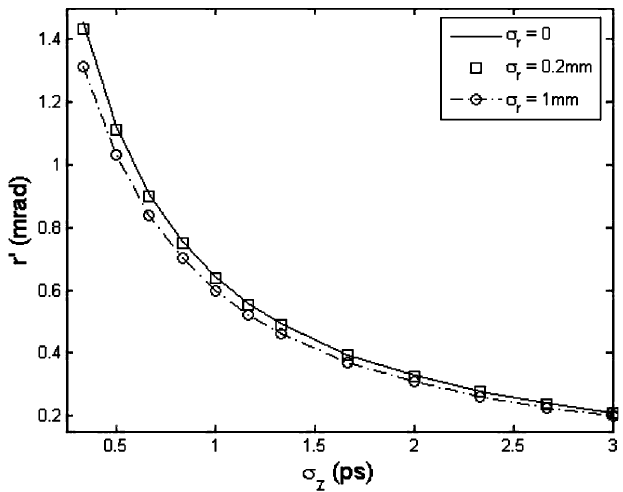
FIG. 5. Influence of transverse beam size on DR